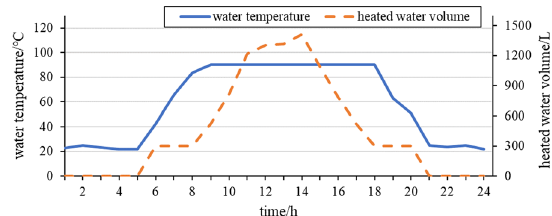
Fig. 10 Water temperature and heated water volume of collector in